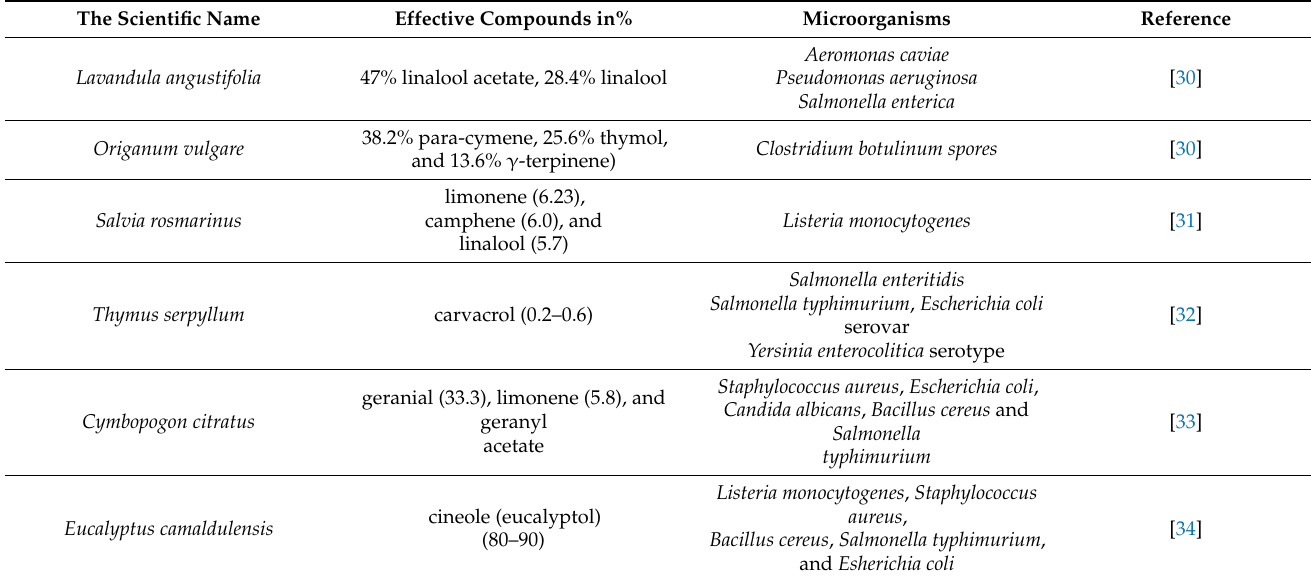
Table 1. EOs and plant extracts with antimicrobial properties that are used in the food